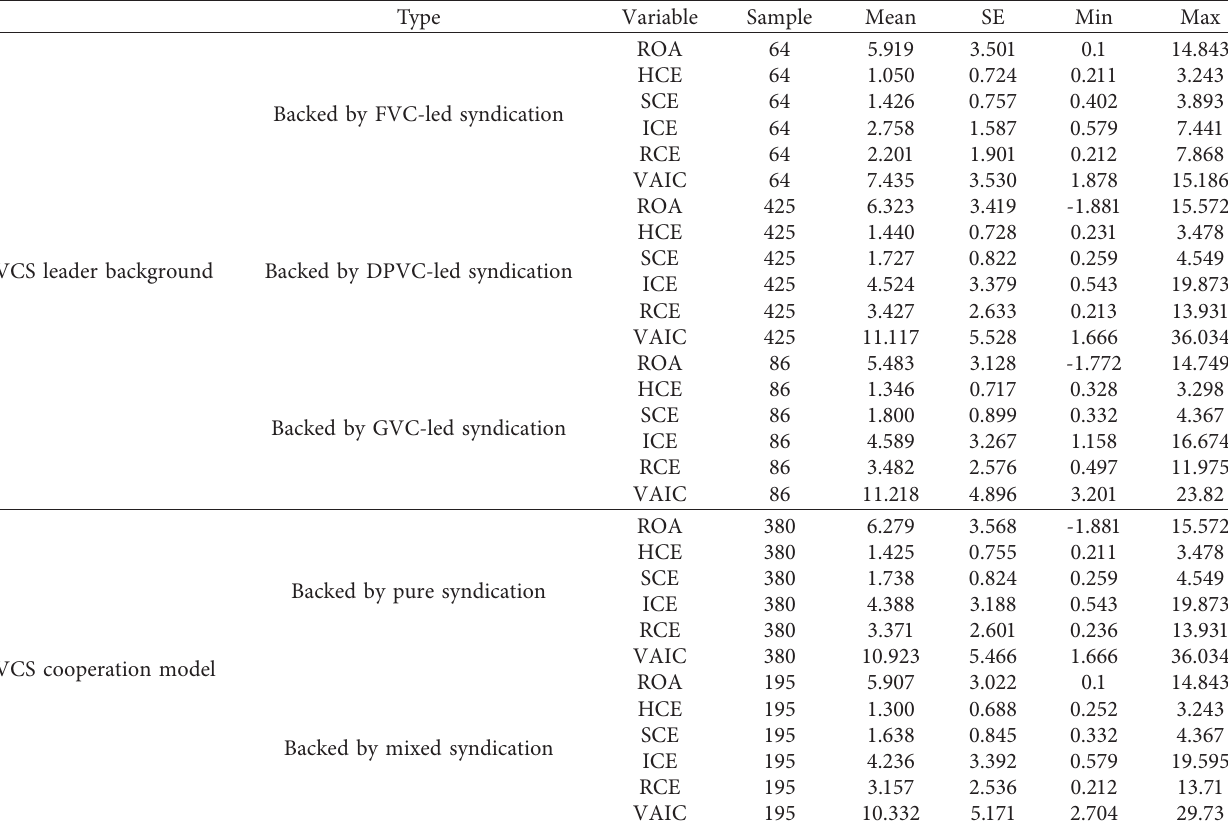
Table 3: Descriptive statistical analysis of the main study